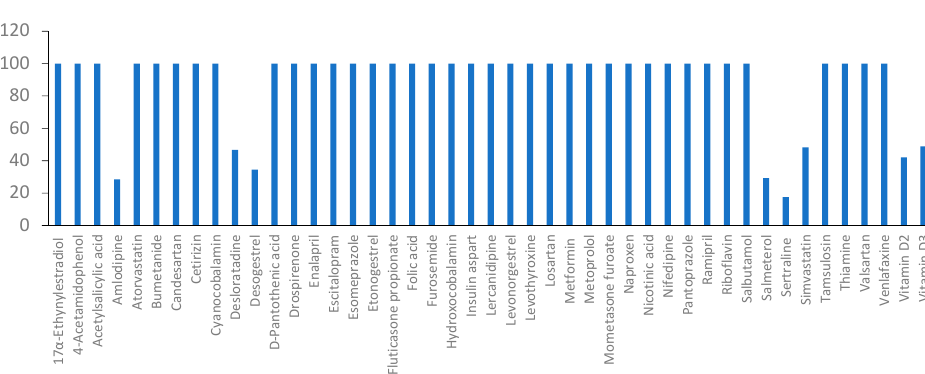
Figure 3. Effect of 45 active compounds of commonly prescribed drugs on the viability of mock- and FLUAV-infected RPE cells. CC 50 and EC 50 values are shown in blue and orange, respectively (mean, n = 3). CC 50 = 100 means >100 μ M.